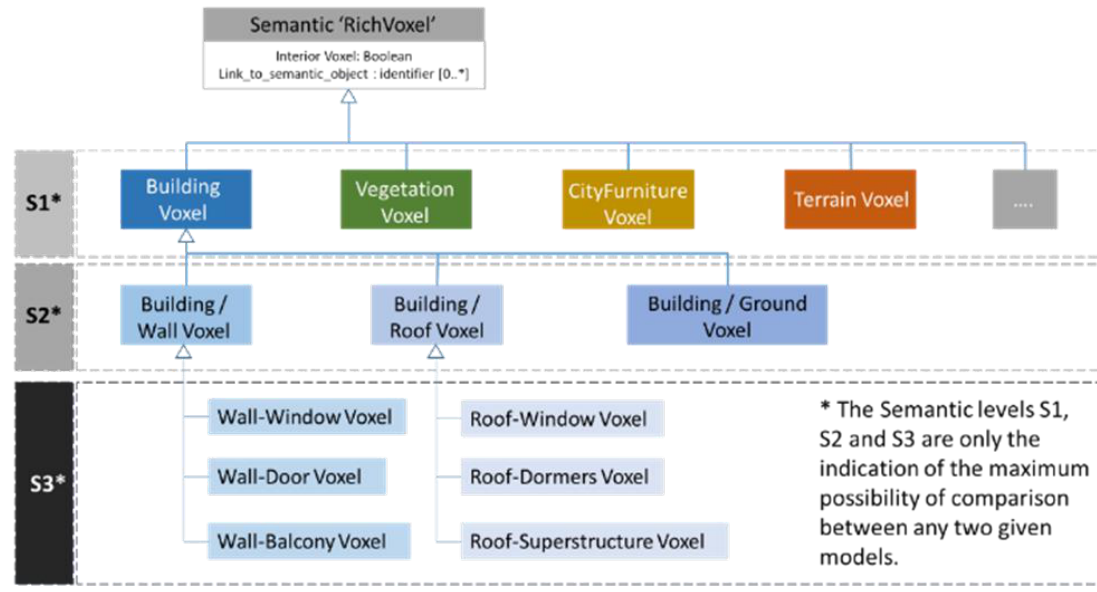
Figure 5 A conceptual understanding of the class hierarchy required in a 'RichVoxel  The ‘RichVoxel’ would also need to hold additional data such as the location coordinates, spatial reference system, RGB colour information, opacity/transparency data, material information, class labels,